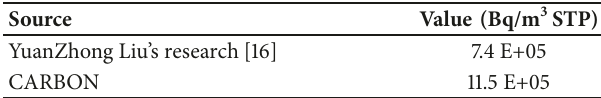
Table 5: The comparison of design value and NORMAL calculation results of the airborne radioactive discharge of HTR-PM under normal operation condition.